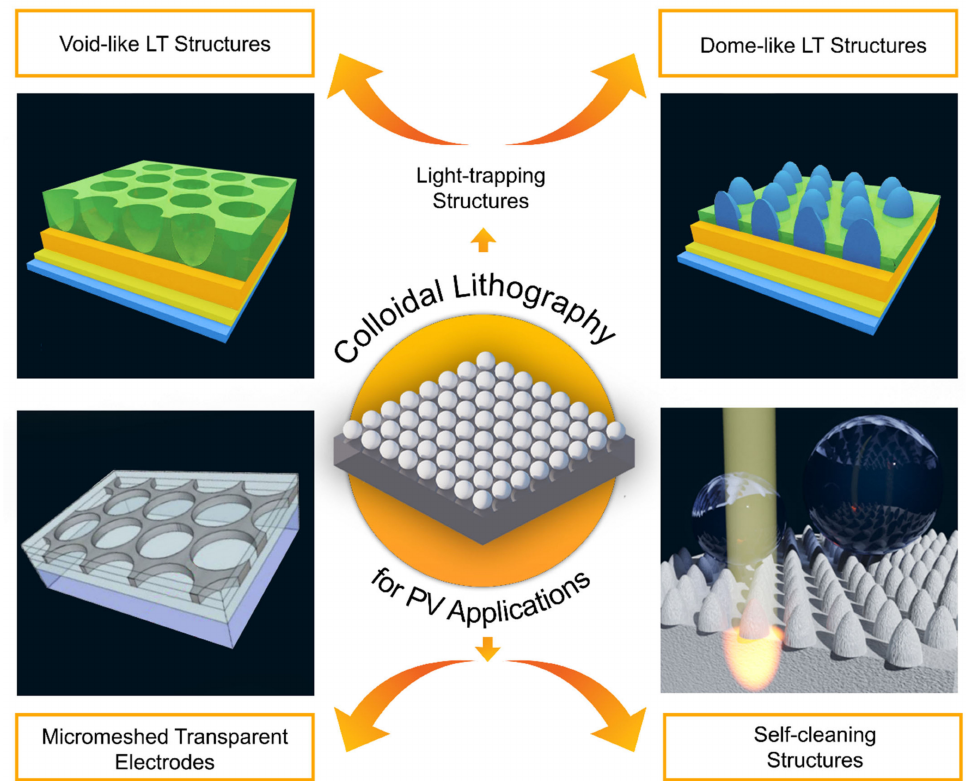
Figure 9. Illustration of the distinct applications of CL for micro-structuring in photovoltaics. Adapted with permission from [62]. Copyright 2021 Elsevier. Adapted with permission from [52]. Copyright 2021 Elsevier. Adapted with permission from [31]. Copyright 2021 John Wiley and